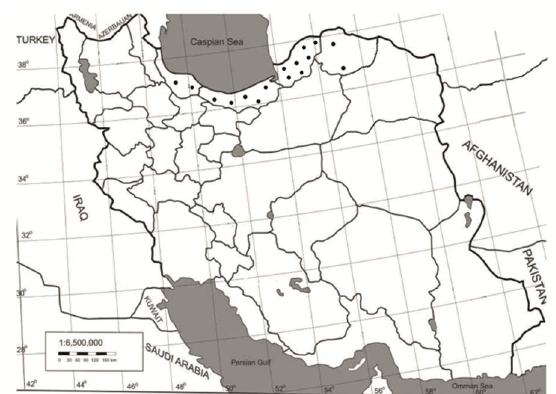
Fig. 1. Geographical location of studied specimens of Carpinus orientalis populations in